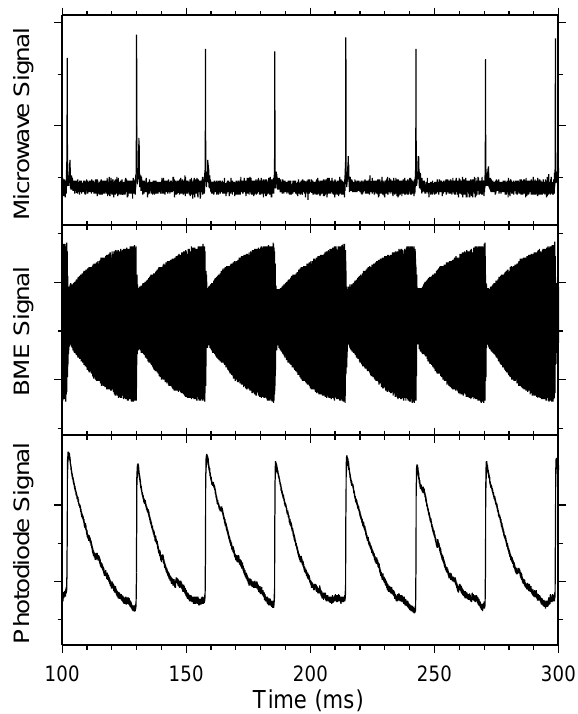
FIG. 1. Top: microwave signal; middle: beam monitor elec- trode signal; bottom: photodiode signal. The data were col- lected at E 0 (cid:1) 255.9 MeV, I B (cid:1) 87.6 mA, V rf (cid:1) 10.7 kV, and f rf (cid:1) 32.4 ± . The time correlation between the different signals is very clearly exhibited. The period of the microwave power bursts is 27.9 ms. The FWHM of the main microwave bursts is about 0.13 ms. A second much smaller peak follows with 1 ms delay and FWHM 0.34 ms. The signal levels are omitted because they are not meaningful, since they depend strongly on the collection